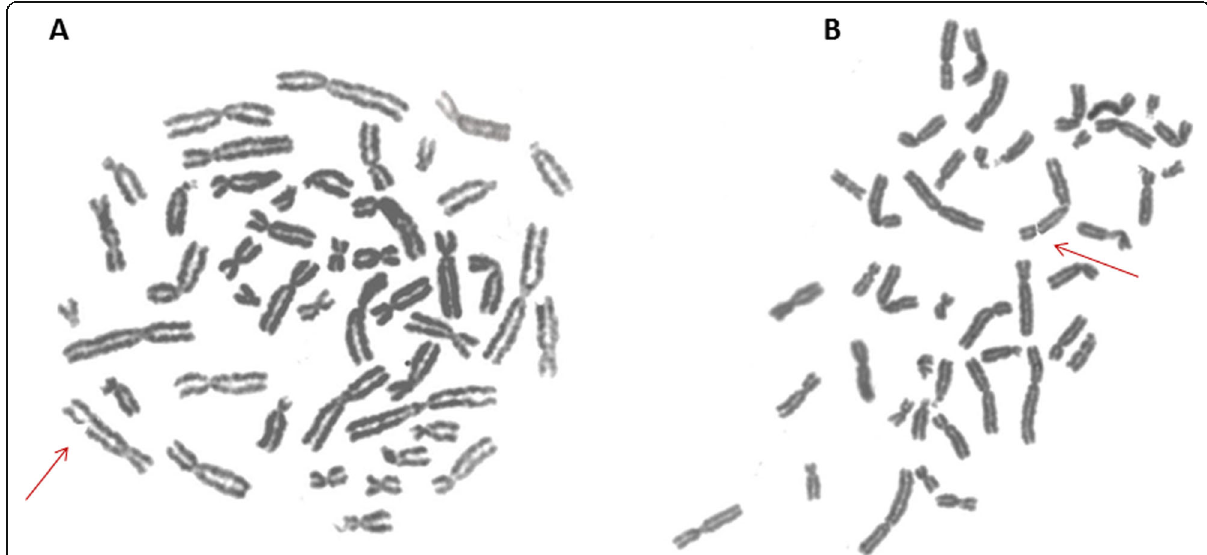
Fig. 2 Images of chromosome aberrations observed in DS mothers. a A metaphase with solid stain showing chromatid break at the long arm of chromosome 5. b A metaphase with solid stain showing chromosome break at the long arm of chromosome 1